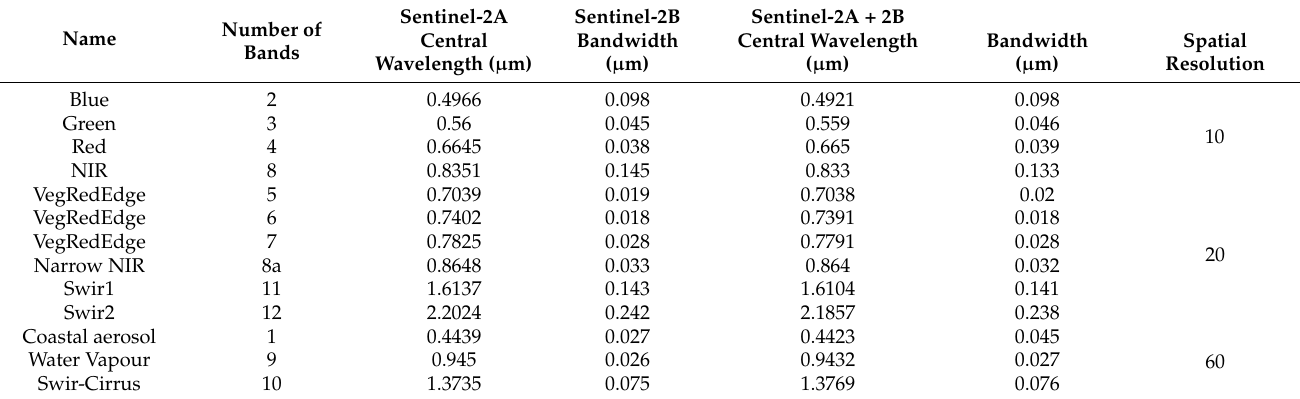
Table 1. Nominal features of S2.